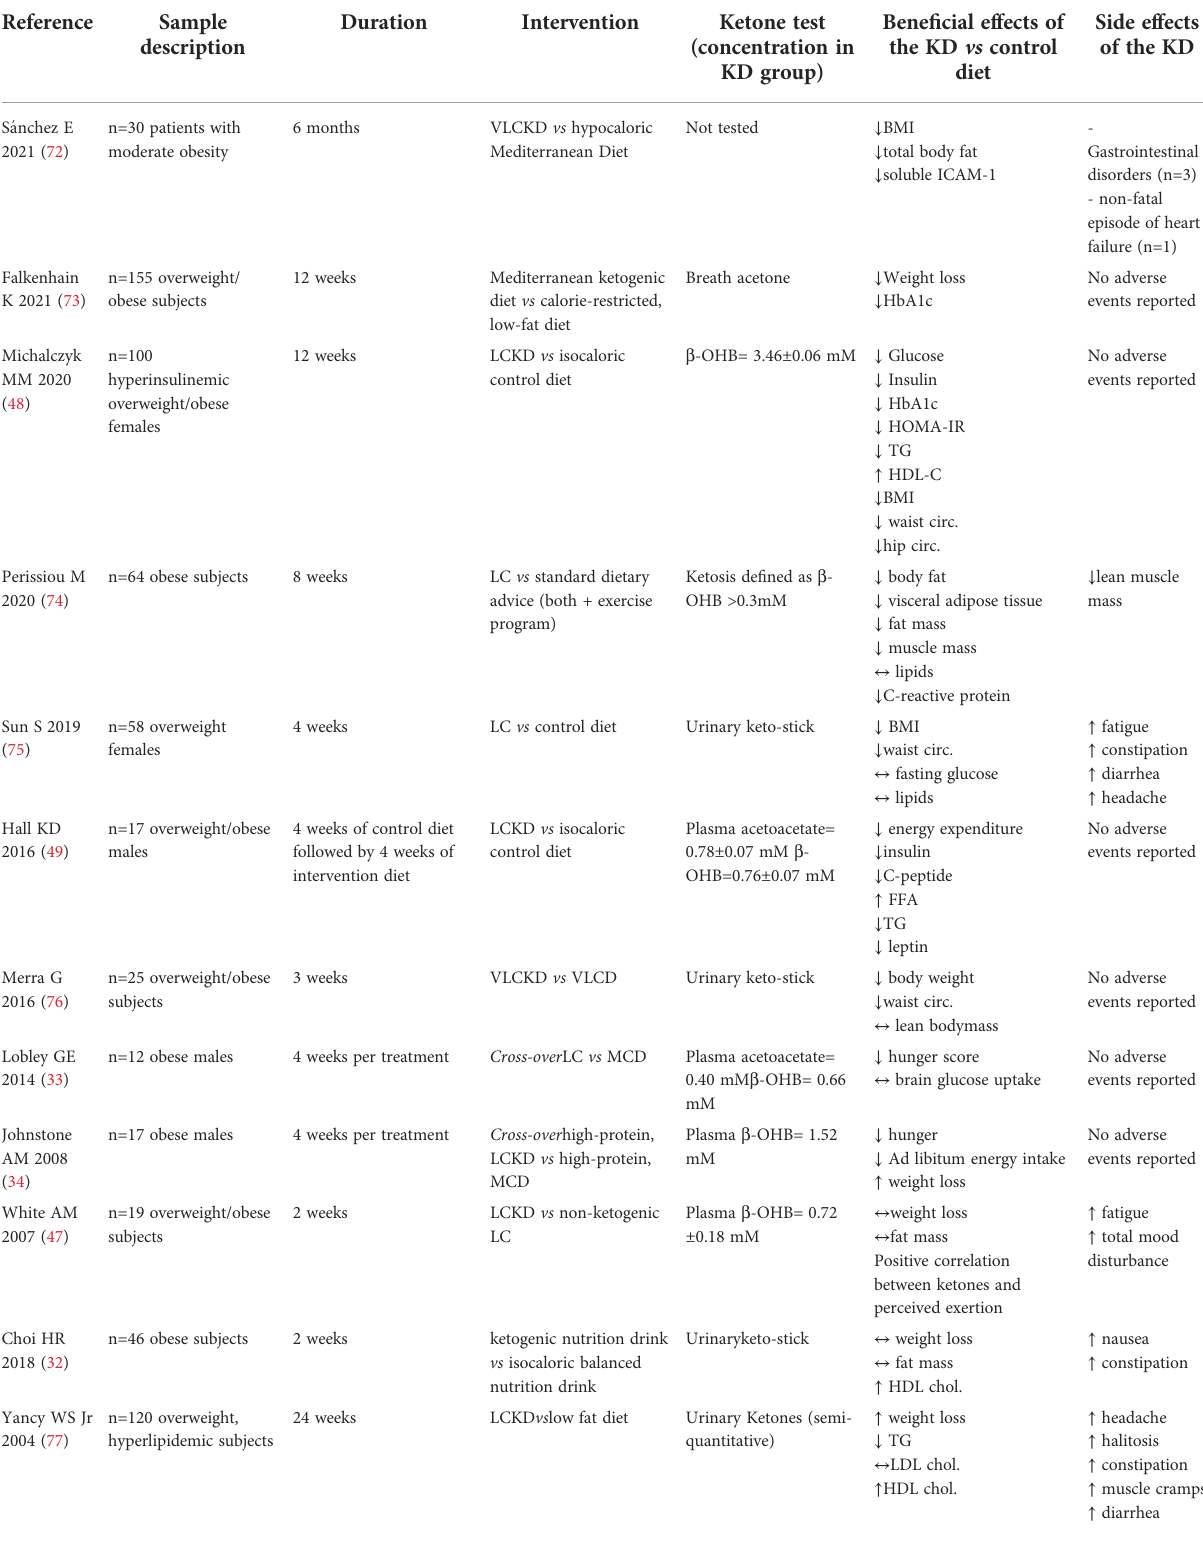
TABLE 2 Summary of trials evaluating KD effects vs comparative diet in obese